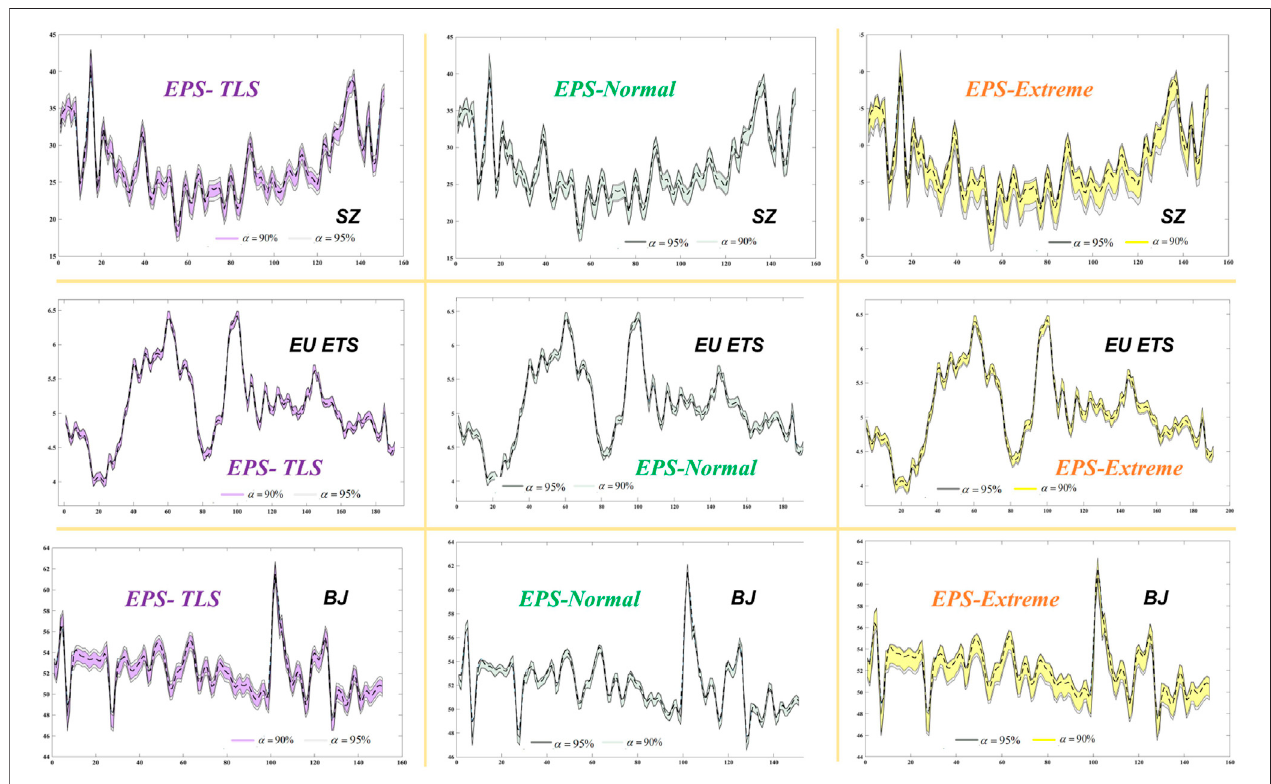
FIGURE 5 | Carbon price prediction intervals generated by the three proposed schemes.